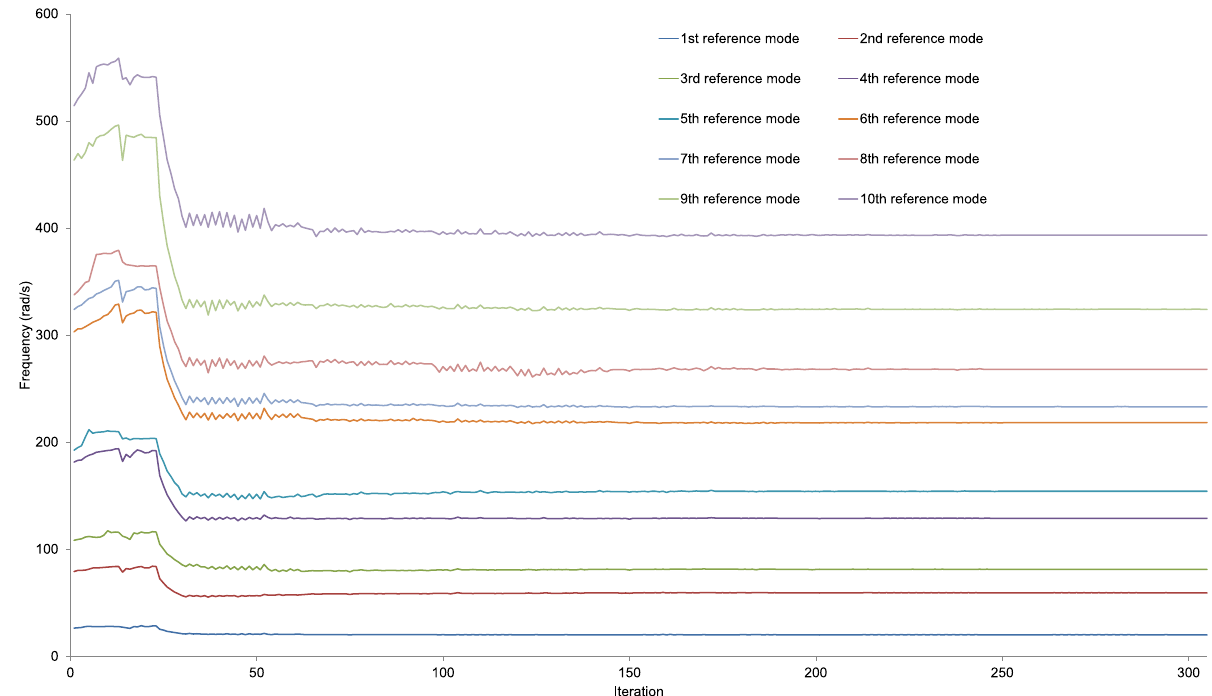
Fig. 8. Evolution of the natural frequencies of the current model sorted according the best corresponding reference modes. manipulation before the final output of the generalized modal masses of the scaled model given by the finite element